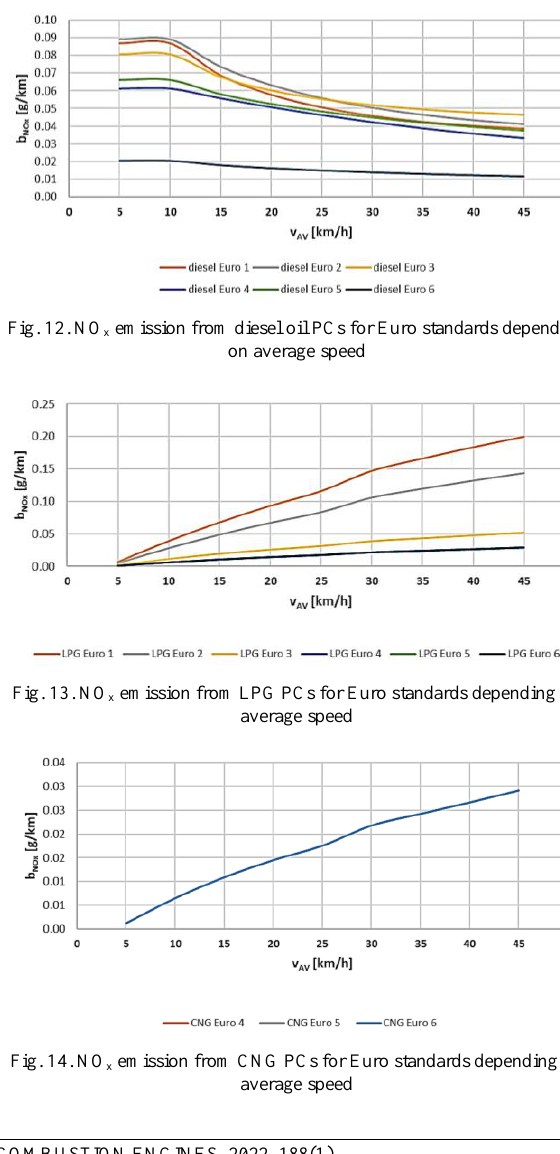
Fig. 11. NO x emission from petrol PCs for Euro standards depending on average speed